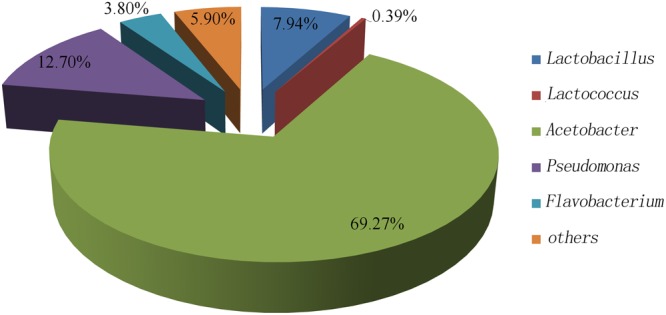
The sour liquid bacterial community at genus level.